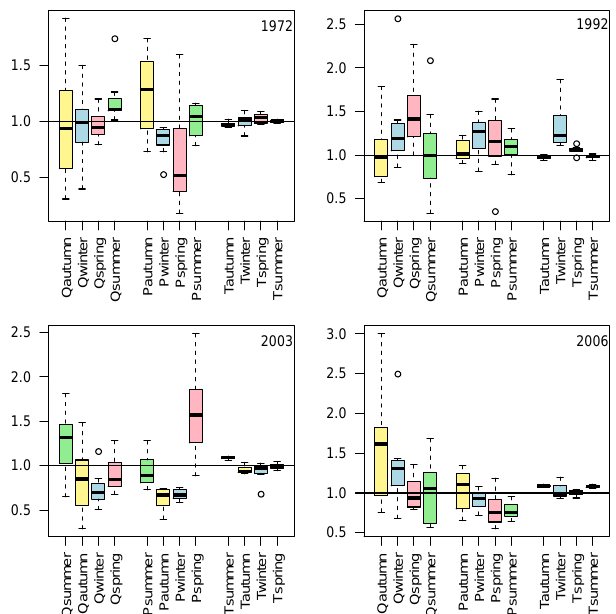
Figure 11. Anomalies of hydrometeorological variables for selected drought events in Norway (below 1 = below average; above 1 = above average). Boxplots represent values for all eight catchments in Norway.